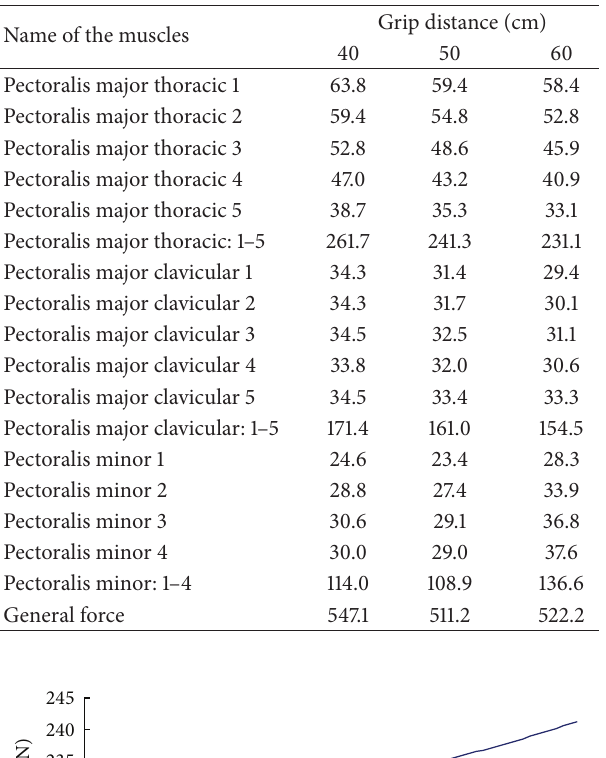
Table 2: The major pectoralis muscle using varying grip widths with identical forces (unit: 𝑁 ).